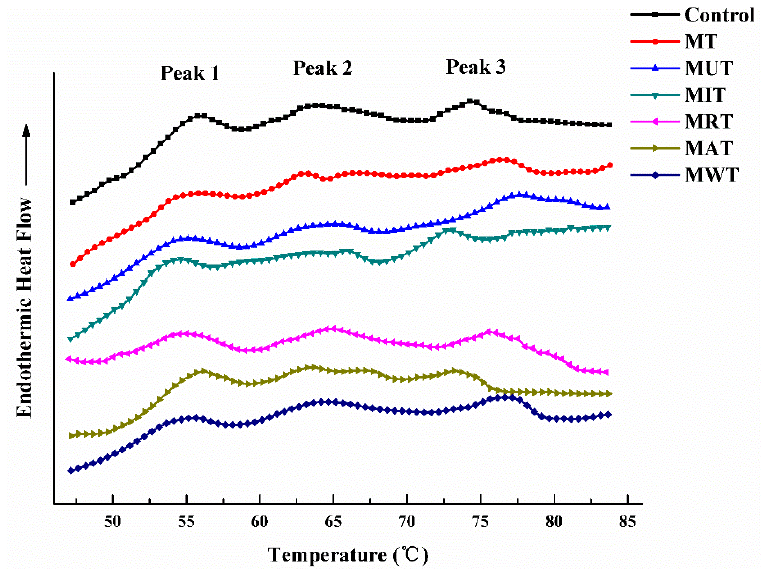
Figure 5. Typical differential scanning calorimetry (DSC) scans of the muscle proteins in pork under six different thawing conditions. MT: Microwave thawing (100 W); MUT: Microwave combined with ultrasonic thawing; MIT: Microwave combined with 35 °C water immersion thawing; MRT: Microwave combined with 4 °C refrigeration thawing; MAT: Microwave combined with air convection thawing; MWT: Microwave combined with running water thawing.